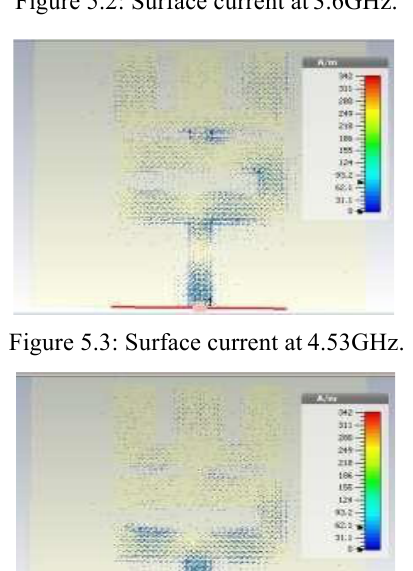
Figure 5.2: Surface current at 3.6GHz.